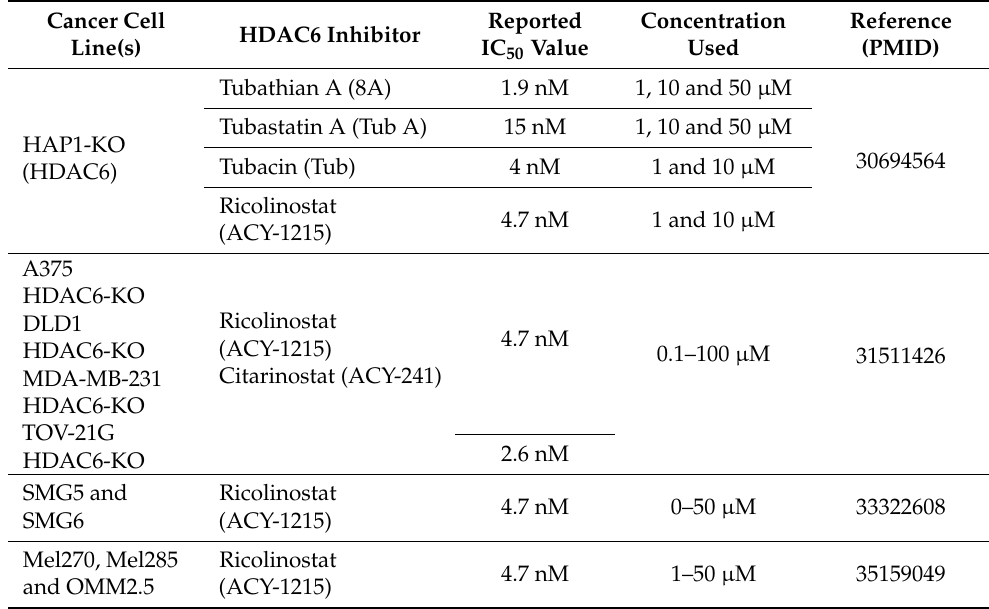
Table 3. Concentration of HDAC6 inhibitors used in